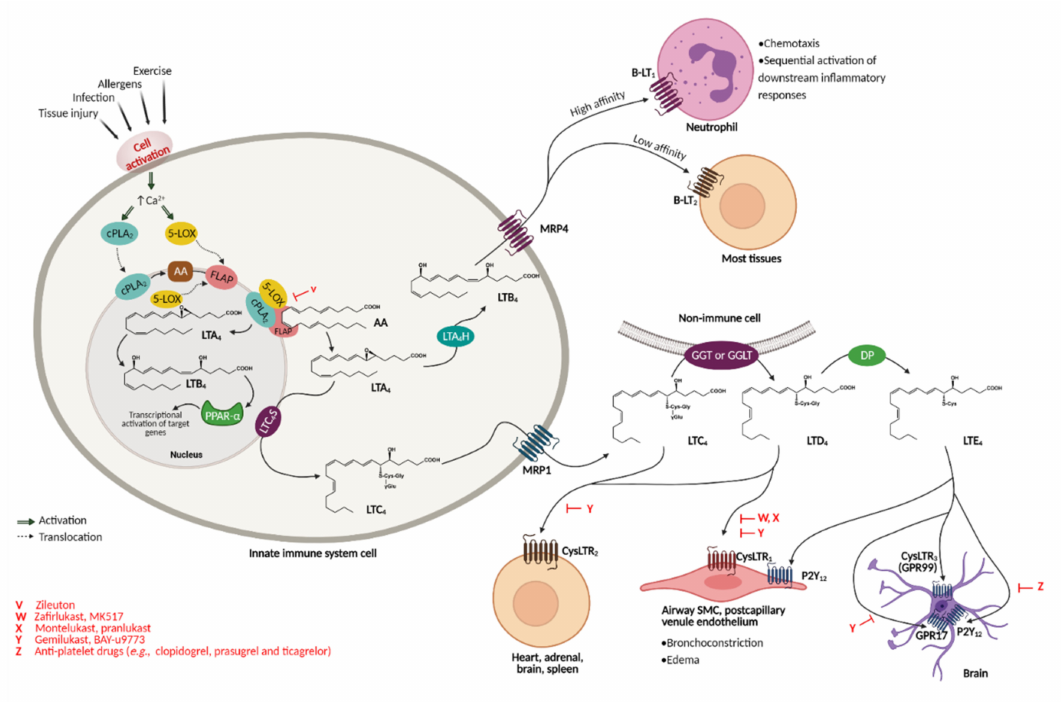
Figure 1. Leukotriene biosynthesis pathway and receptor recognition. Leukotrienes are synthesised upon activation of the immune system through an LT biosynthesis cascade, acting on various organs through different receptors. V is a 5-LOX inhibitor, whereas W, X, Y, and Z are inhibitors of the leukotriene pathways; all are marked in red. Image adapted from Funk [19]. Created with